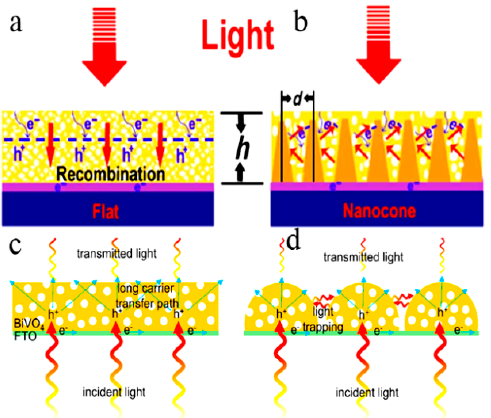
Figure 3. Optical absorption and electron transport on nanoporous BiVO 4 with ( a ) the flat substrate and ( b ) the conductive nanocone substrate. Reprinted with permission from ref. [9]. Copyright 2016. Science. ( c ) flat BiVO 4 film and ( d ) hierarchical BiVO 4 nanostructured film. Reprinted with permission from ref. [10]. Copyright 2008. American Chemical